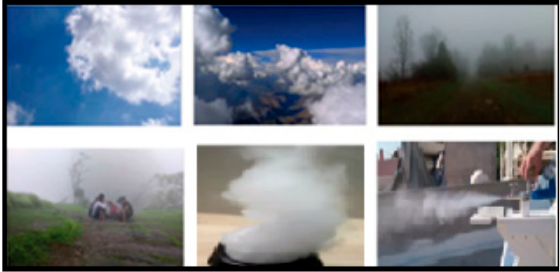
Figure 2. The environments and samples of smoke video database: examples of frames. Including smoke, moving people, clouds, or fogs.